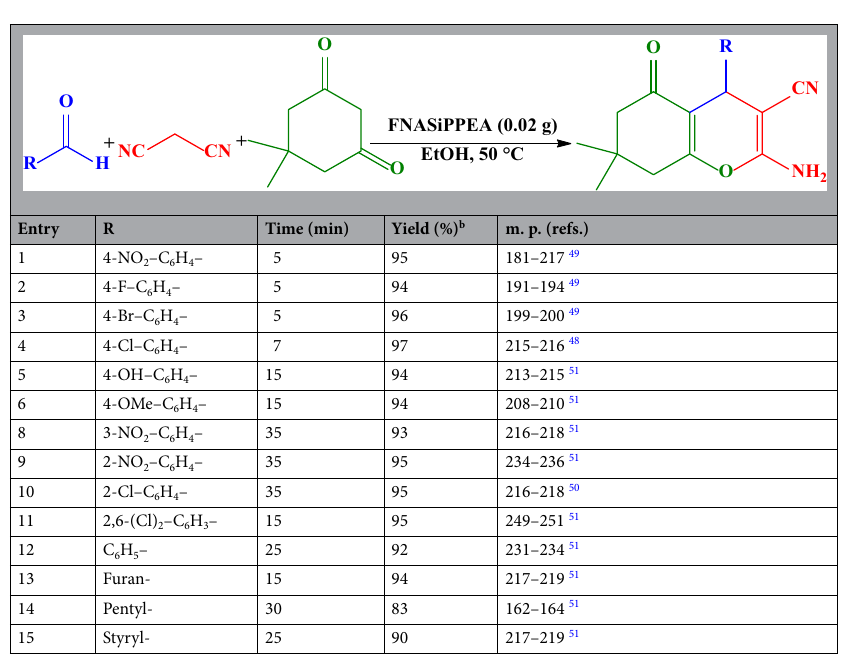
Table 5. Synthesis of THBP derivatives catalyzed by FNASiPPEA. a a Conditithons: aldehyde (1 mmol), dimedone (1 mmol), malononitrile (1.5 mmol), 50 °C, EtOH as the solvent, catalyst (0.02 g), b Isolated